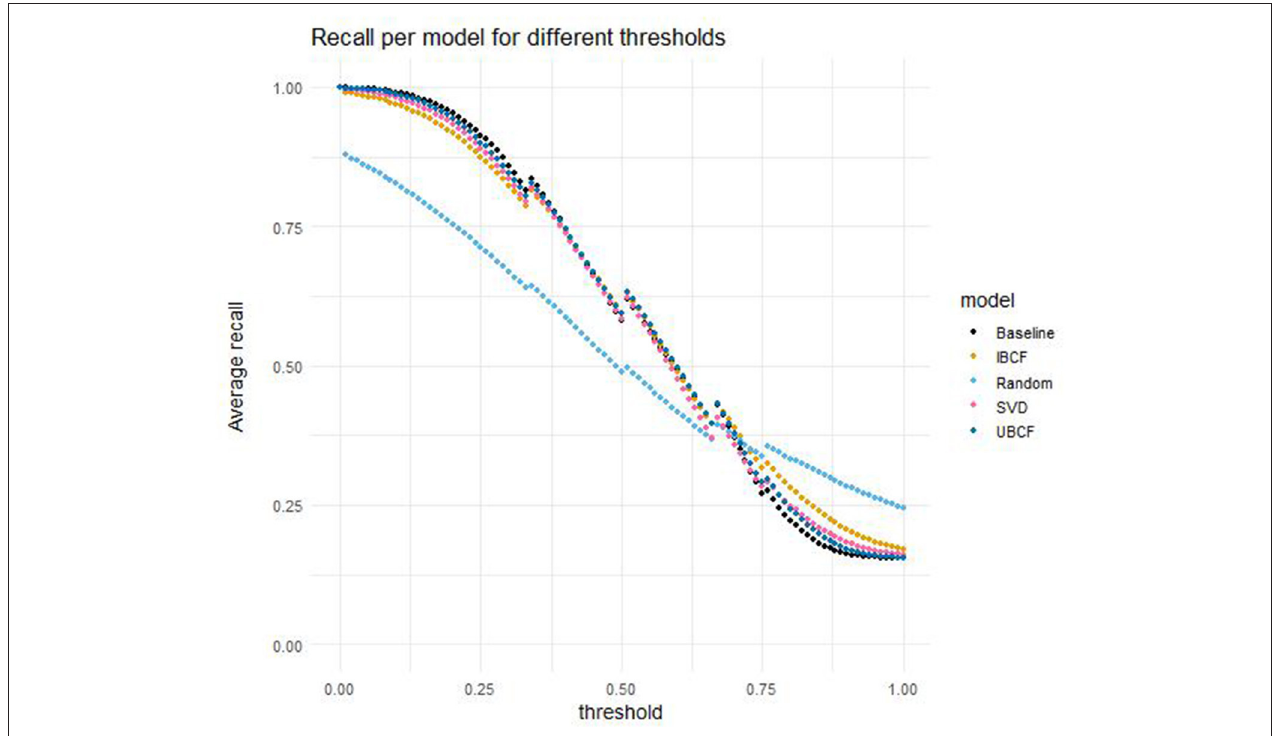
FIGURE 4 | Recall per model for different thresholds, averaged over students and cross-validation